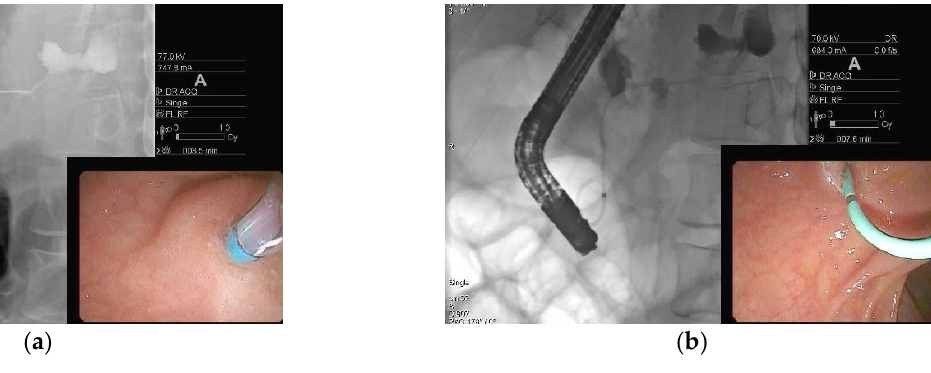
Figure 5. Endoscopic retrograde pancreatography in a patient with disconnected duct syndrome (DDS). ( a ) Pancreatogram showing extravasation of contrast from the pancreatic duct in the body of the pancreas. The pancreatic duct in the tail is not opacified. The above findings are suggestive of complete DDS; and ( b ) pancreatic sphincterotomy followed by pancreatic duct stent placement.